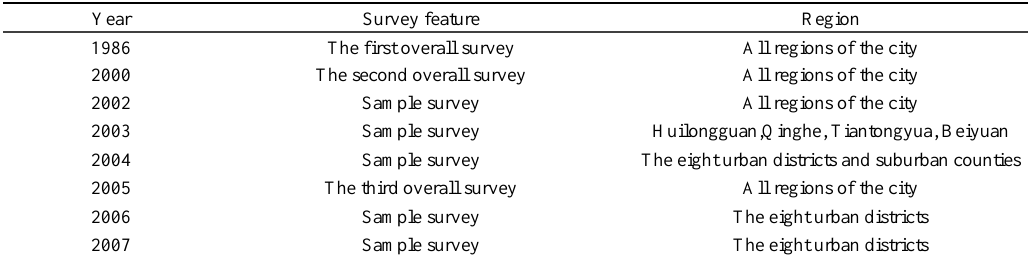
Table 1: Transportation surveys in